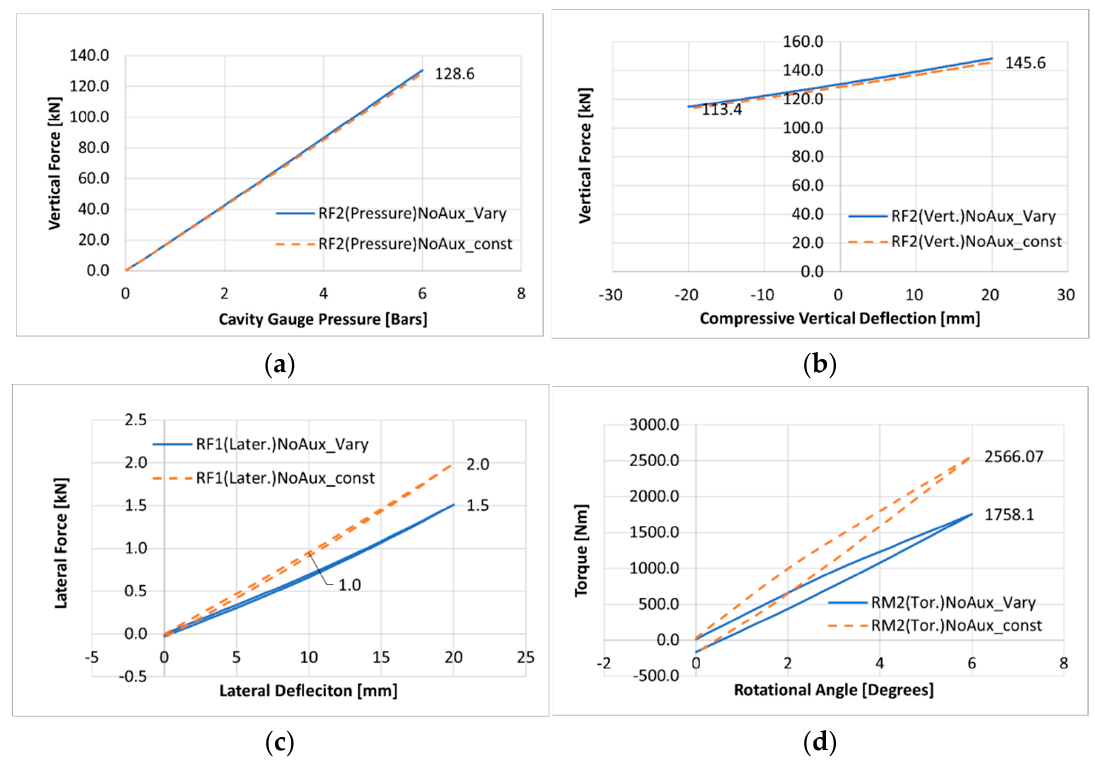
Figure 14. Variation of characteristic data for the air spring simulation: ( a ) Vertical force vs. internal pressure; ( b ) Vertical force vs. compressive deflection; ( c ) Lateral force vs. lateral deflection; ( d ) Torque vs. rotation. Table 1. Comparisons of characteristic data with respect to the ply angle variation for the air spring analysis at inflating pressure of 6 bars.